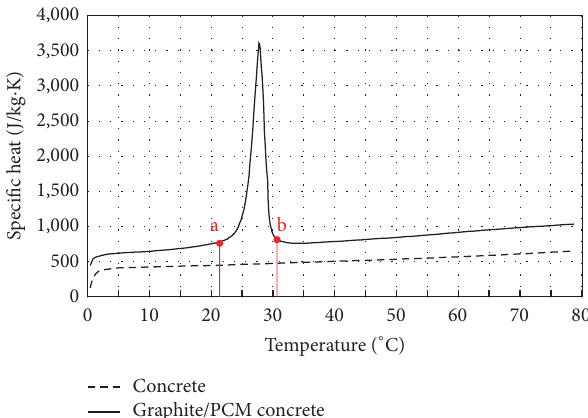
Figure 3: Specific heat of concrete and concrete with